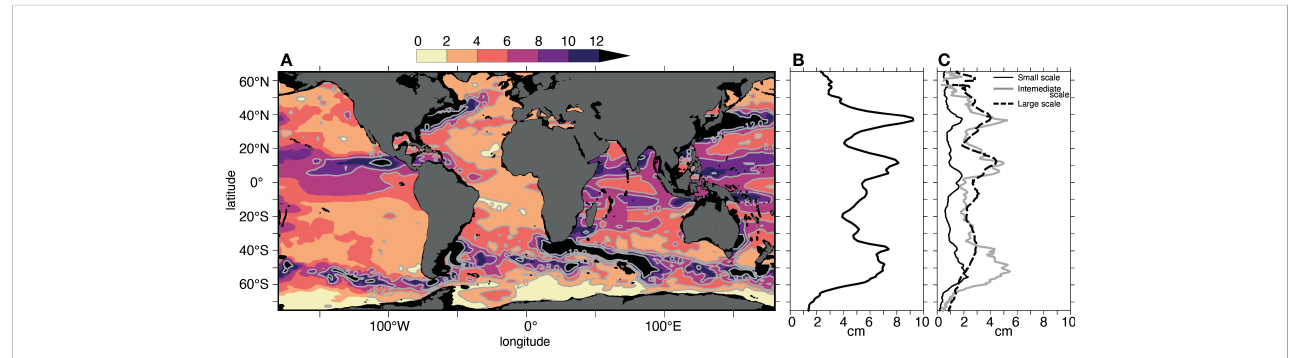
FIGURE 4 Standard deviation of the daily steric height (SH, cm) from the FREE experiment (A) spatial map, (B, C) zonal-average, black line). For comparison, zonally averaged standard deviation of the daily SH fi elds of the small scales (black line), intermediate (gray line) and large-scale variability (dashed line) are also